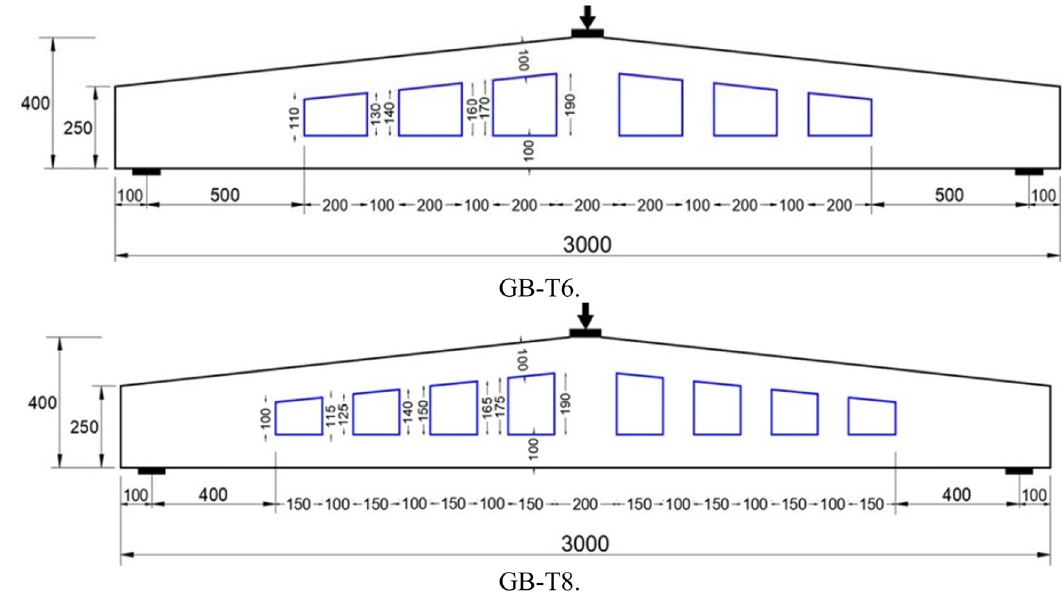
Figure 2: An architecture of group A ( all dimensions are in mm )